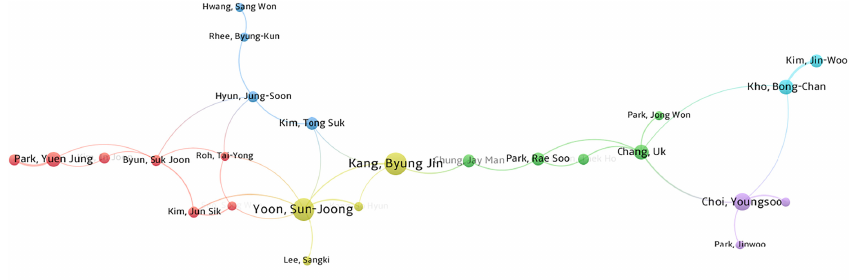
Figure 2. Author-level